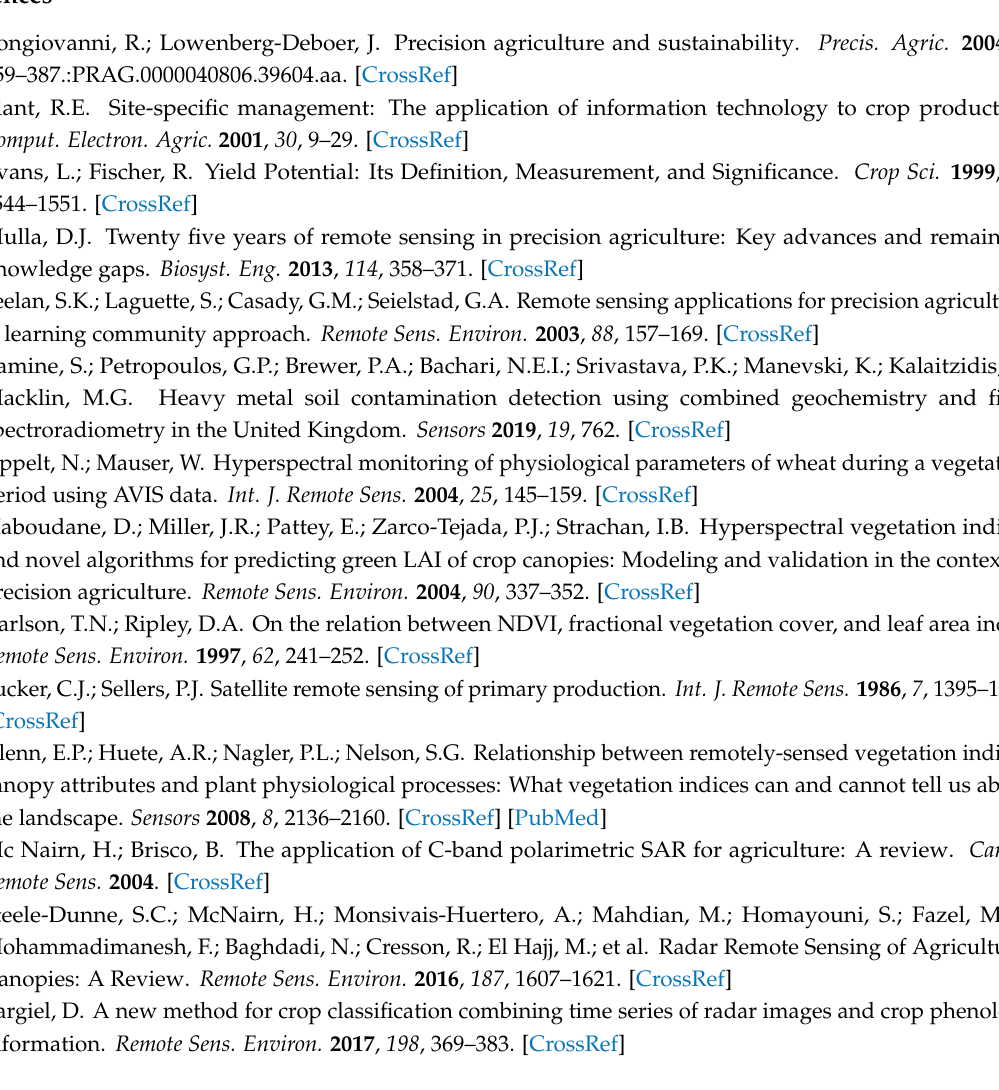
s1, Figure S1: Scatter plots of crop parameters related to backscatter parameters for all barley fields in 2017 and 2018. Figure S2: Bar plots of R 2 values of regression between crop and backscatter parameters per crop type for single fields. Figure S3: Bar plots of R 2 values of regression between crop and backscatter parameters per crop type for single fields in BBCH stages 51–77. Figure S4: Bar plots of R 2 values of regression between crop and backscatter parameters per crop type for single fields in BBCH stages